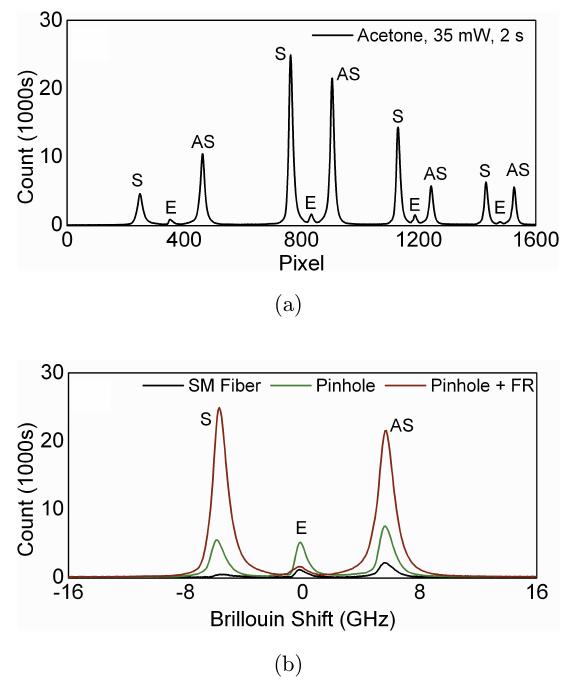
Fig. 3. Brillouin spectrum acquired with the optimized sys- tem. The exposure time was 2 s, and the incident power was 35 mW. (b) Comparison between di®erent VIPA spectrometer entrances. The \SM ¯ber" result has been zoomed-in by 3 times. The sample was acetone. S: Stokes peak; AS: anti-Stokes peak; E: elastic peak; FR: Faraday